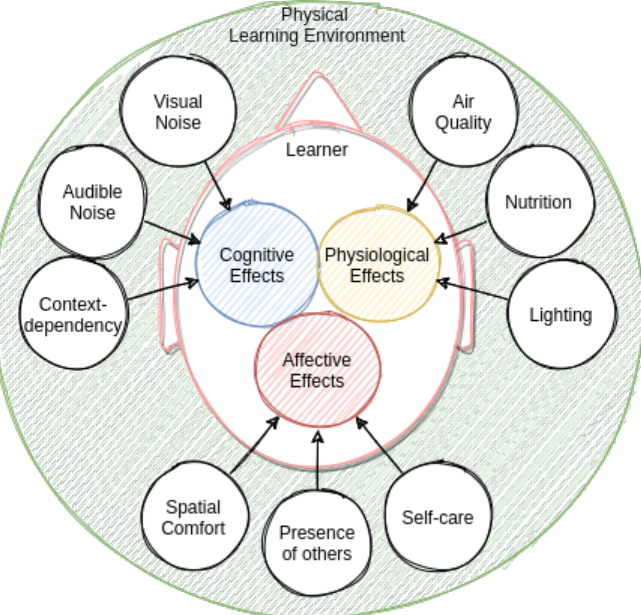
Figure 2. This illustration depicts the relationship between the nine identified factors from the physical learning environment and their effects on learners’ cognition, physiology, and